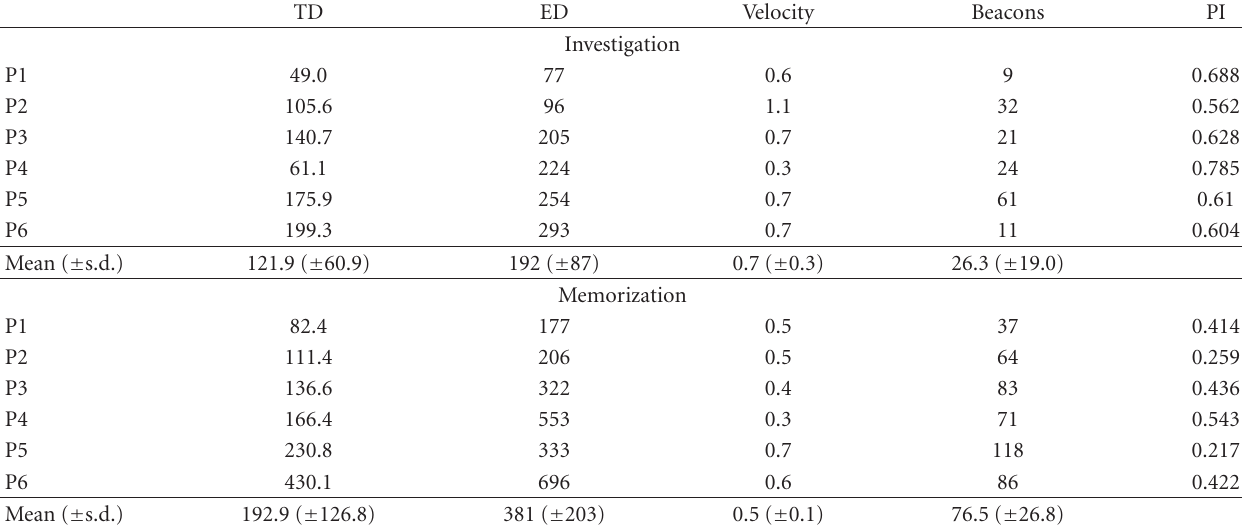
Table 5: Travelled distance (TD in km after conversion of the cursor displacements to the map scale), elapsed duration (ED in sec), velocity (km/sec), number of touched beacons, and parallelism index (PI) for each participant during the investigation and memorization phases. TD ED Velocity Beacons PI Investigation P1 49.0 77 0.6 0.688 P2 105.6 96 P3 140.7 175.9 P6 199.3 293 Mean ( ± s.d.) 121.9 ( ± 60.9) 192 ( ±